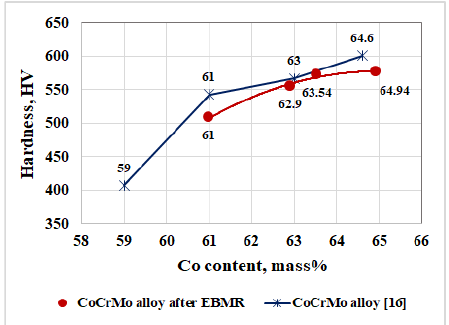
Figure 4. Influence of the EBMR technological parameters on the hardness of the obtained CoCrMo samples under different loads.